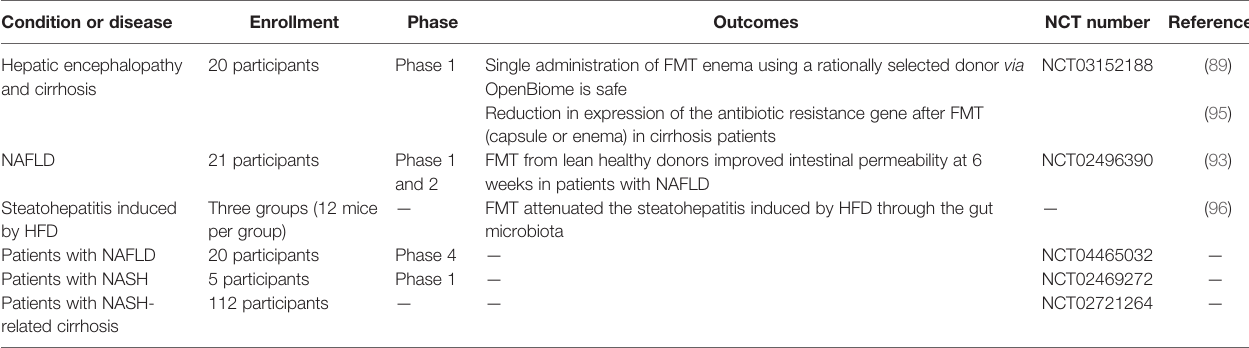
TABLE 3 | Registered clinical trials and animal studies using FMTs to treat liver